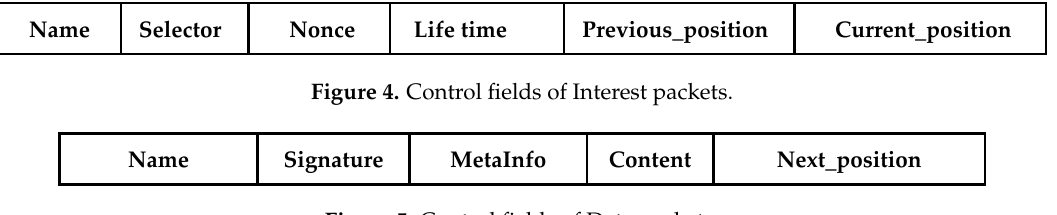
Figure 5. Control fields of Data packets.